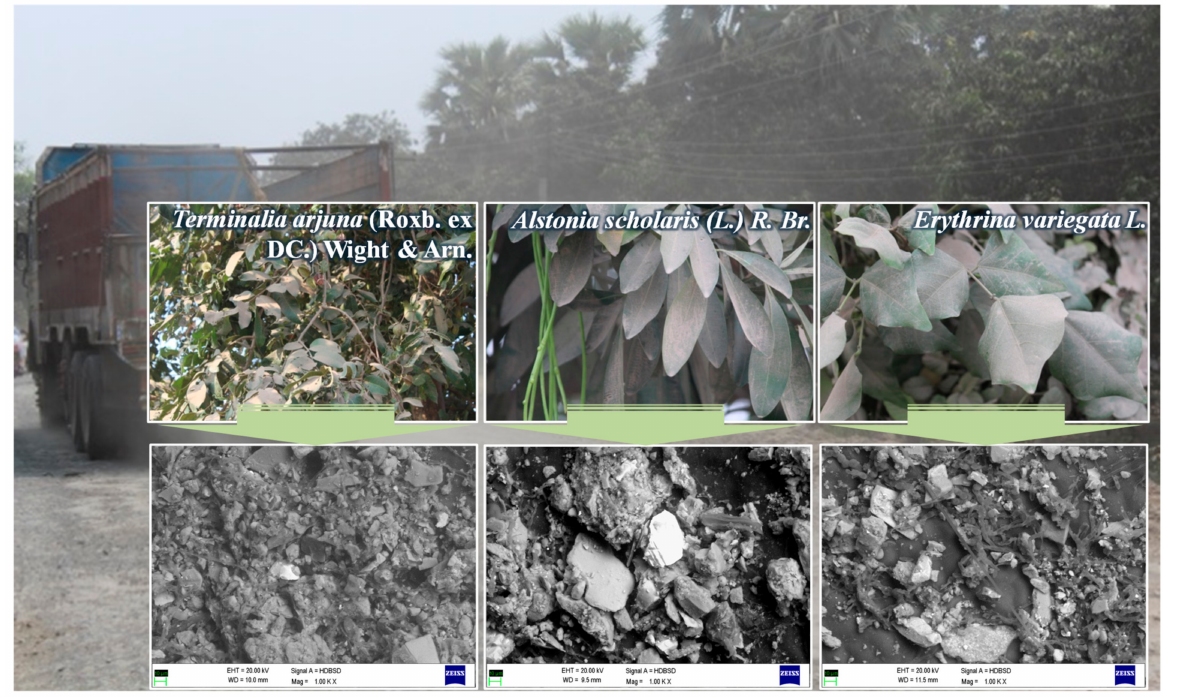
Figure 3. Plants are continuously exposed to heterogenous particulate pollution in urban agglom- erations. Leaves are the primary place for the deposition of PM. Normal and scanning electron microscopic (magnification 1000 × ) images of selected plants with particulate deposition inMalda, West Bengal,